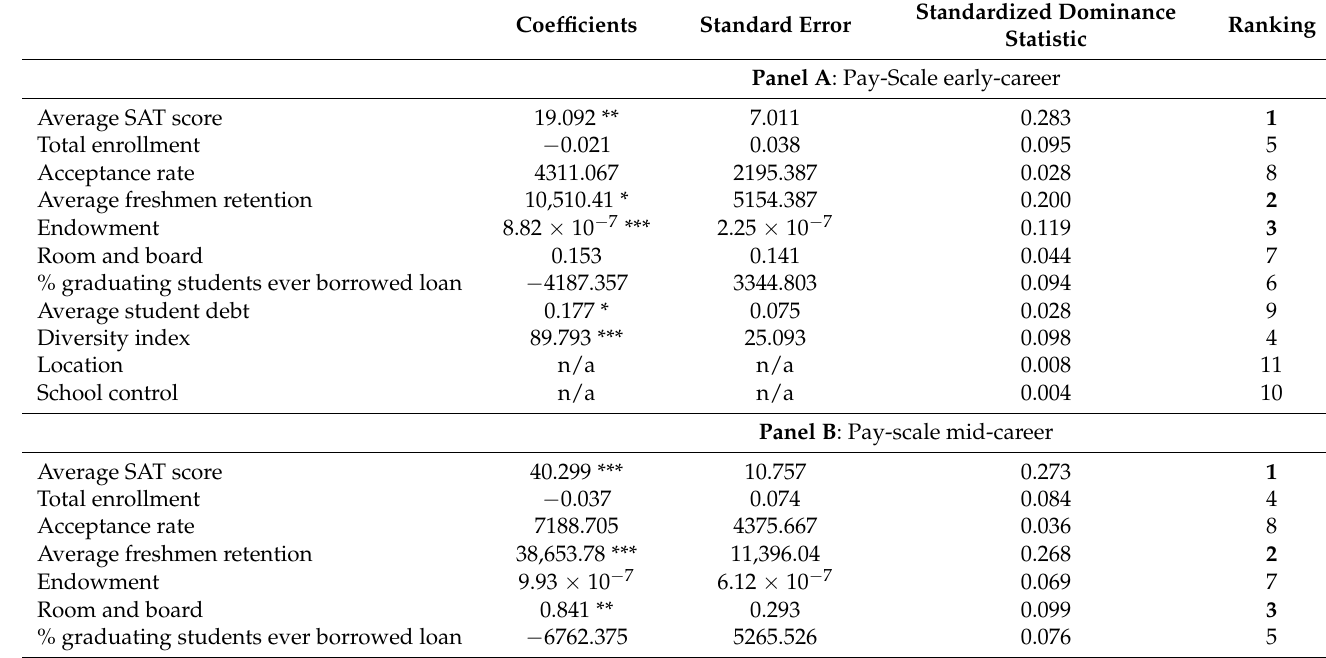
Table 6. OLS coefficients and importance of predictors of student long-term outcomes and school rankings using Model 3, U.S. News